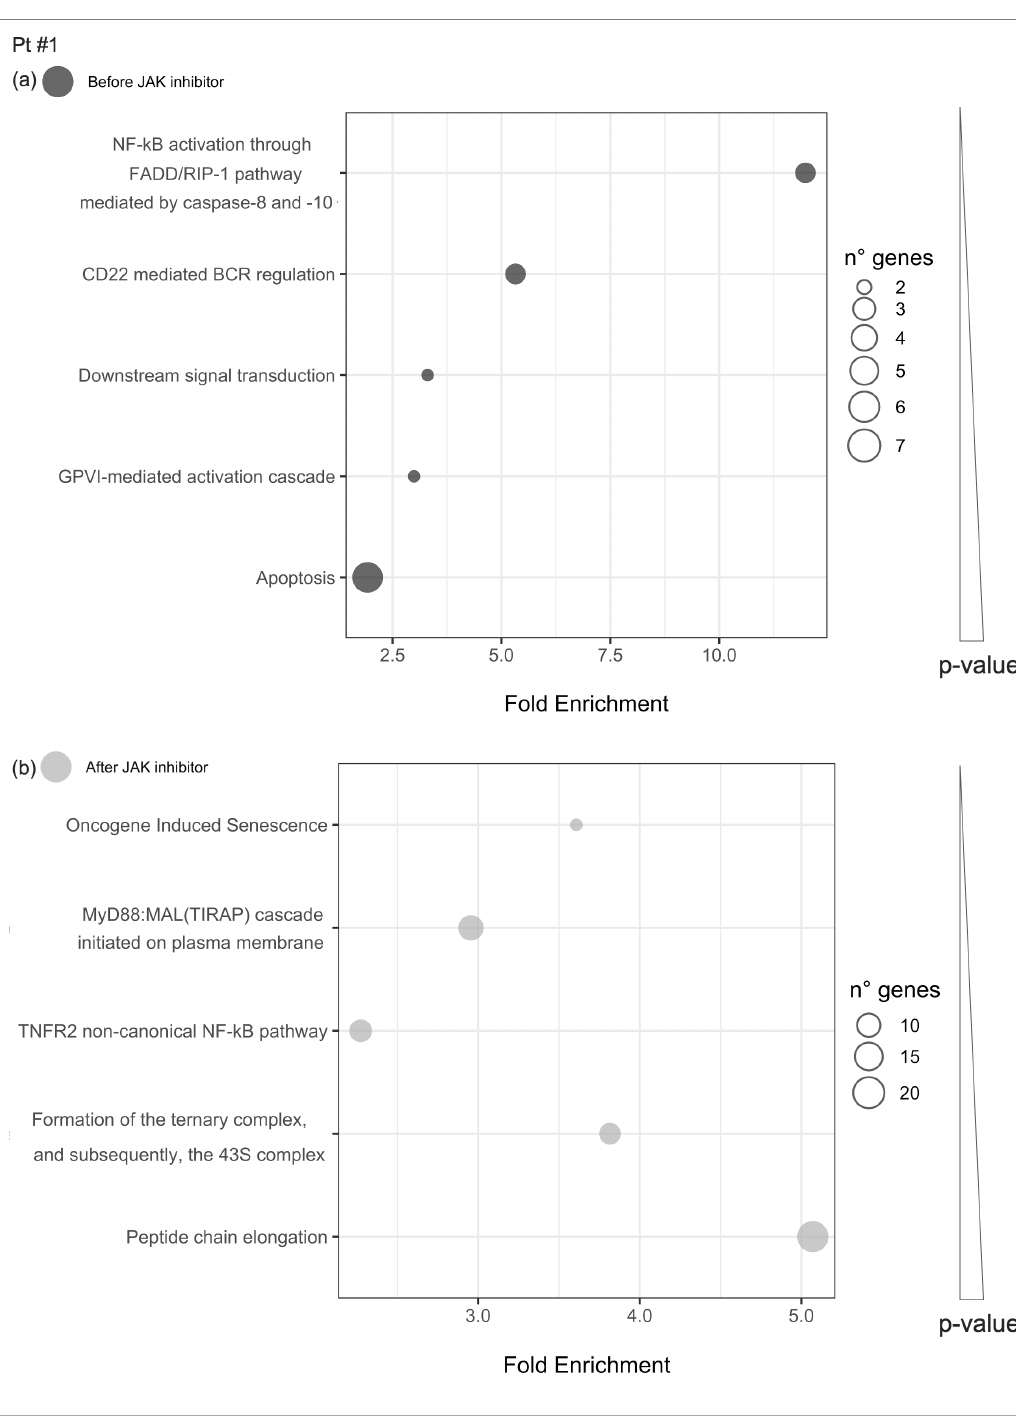
Figure 8. Pathway enrichment analysis was run on di ff erential expressed genes resulting from the comparison between patient #1 before JAKinhibs and the control-group subjects and between patient #1 after JAKinhibs and the controls. Pathways altered uniquely before ( a ) or uniquely after ( b ) JAKinhibs were chosen. Each dot represents a pathway, and the size is directly proportional to the number of genes. On the X -axis the pathway fold enrichment is displayed. All the selected pathways showed a lowest adjusted p -value of the given term over all iterations ≤ 0.01, and the five most enriched pathways were elected, where applicable. Pathways are ordered by increasing p -values. Pathways altered before JAKinhibs are colored in dark grey and those altered after JAKinhibs in light